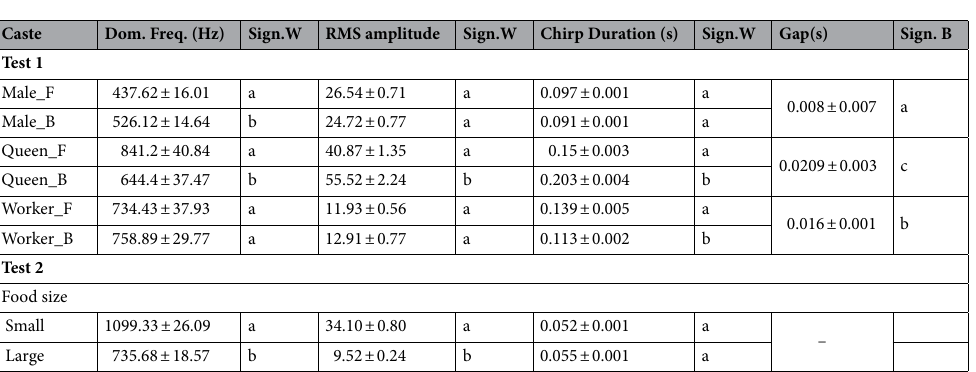
Table 1. Mean values ± standard error of vibrational signal parameters recorded for each caste and in both behavioural contexts. Sign.W significative within caste or food size, Sign.B significative between castes. Common letters are not significantly different (P >